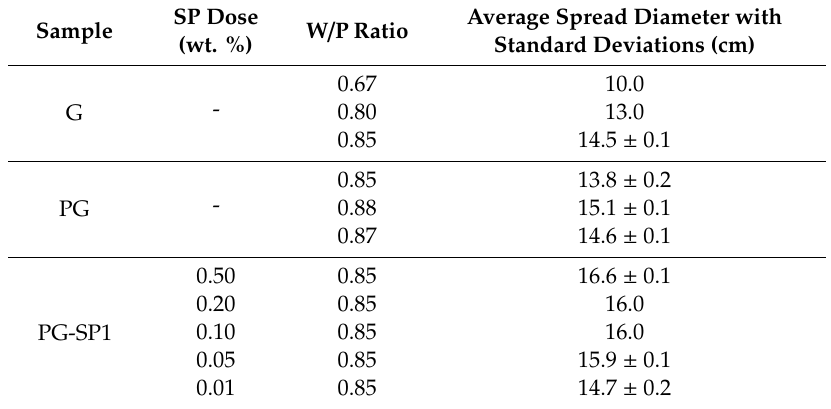
Table 1. Water demand for the normal consistency of gypsum plaster and photocatalytic gypsum